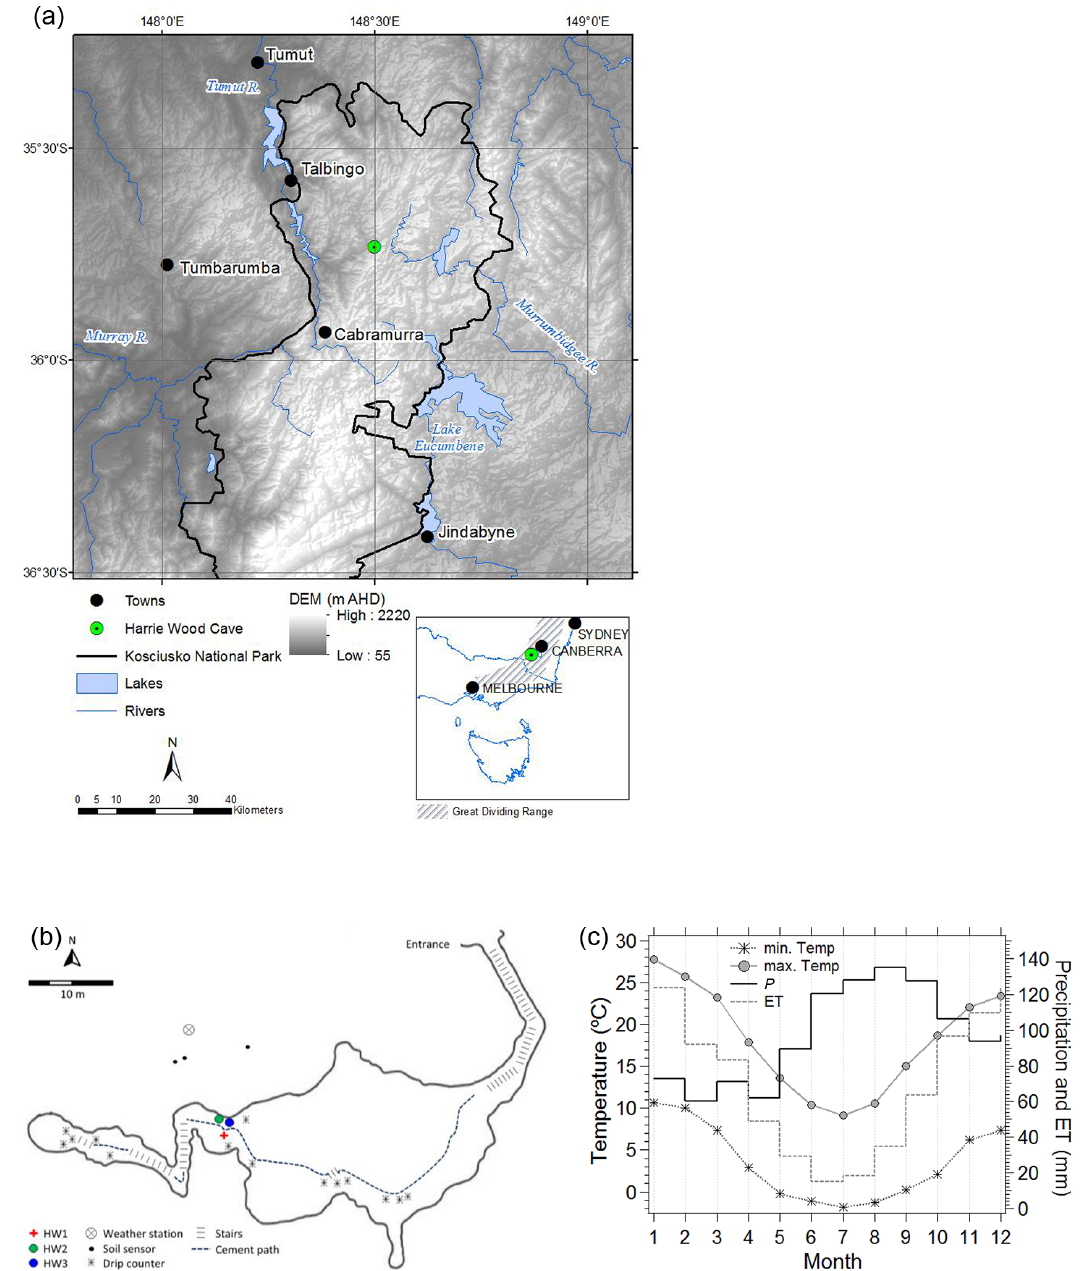
Figure 1. (a) Location of Harrie Wood Cave, Snowy Mountains, Australia. (b) Survey map of the Harrie Wood Cave system (adapted from Nicholl, 1974) showing location of the three drip-water sites (HW1–3), which have been monitored since 2006, the location of automatic drip counters underneath 14 drip sites reported by Markowska et al. (2015), and overlayed is the location of the weather station and